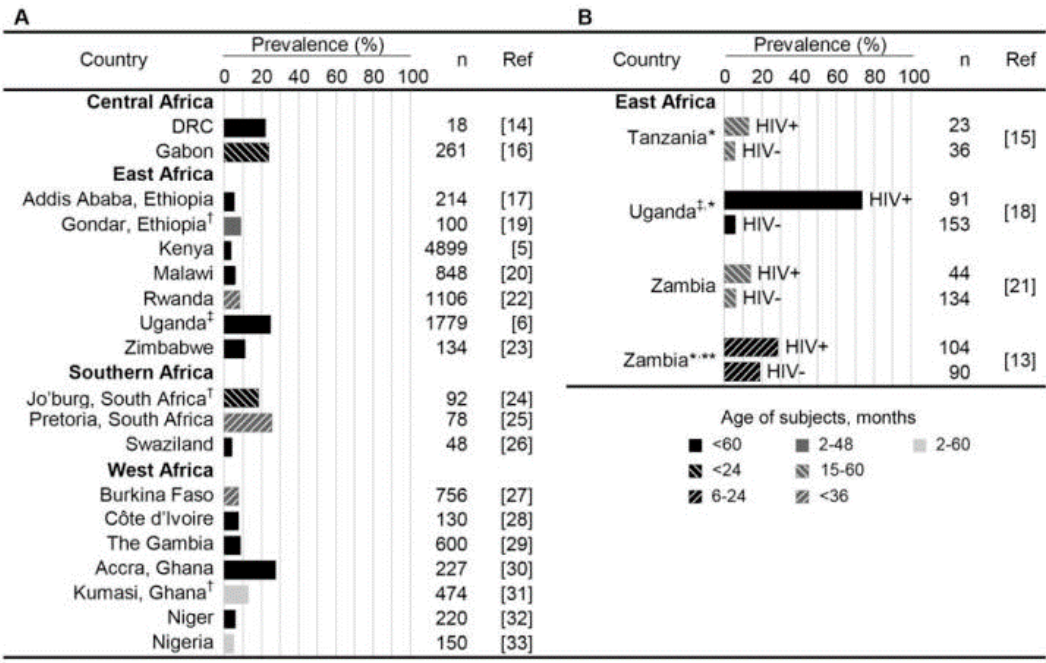
Figure 2. Prevalence of cryptosporidiosis in Africa [5,6,13,51]. Estimates shown are from studies of children under 5 years of age attending health facilities with diarrhoea. Prevalence is reported separately for children with unknown or unreported HIV status ( A ) and known ( B ).